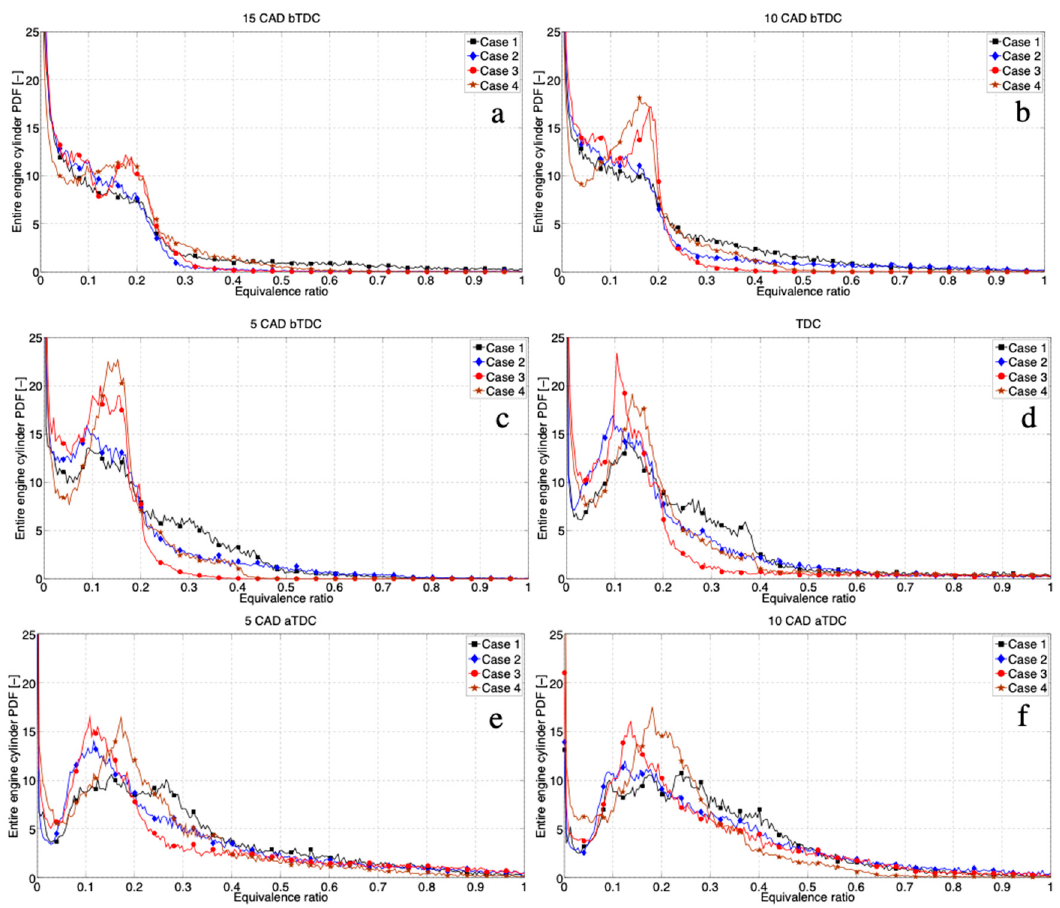
Figure 9. Volume-weighted PDFs for fuel and air mixture distribution as a function of equivalence ratio, for the four cases between − 15 CAD and 10 CAD. ( a ) 15 CAD bTDC; ( b ) 10 CAD bTDC; ( c ) 5 CAD bTDC; ( d ) TDC; ( e ) 5 CAD aTDC; ( f ) 10 CAD aTDC.